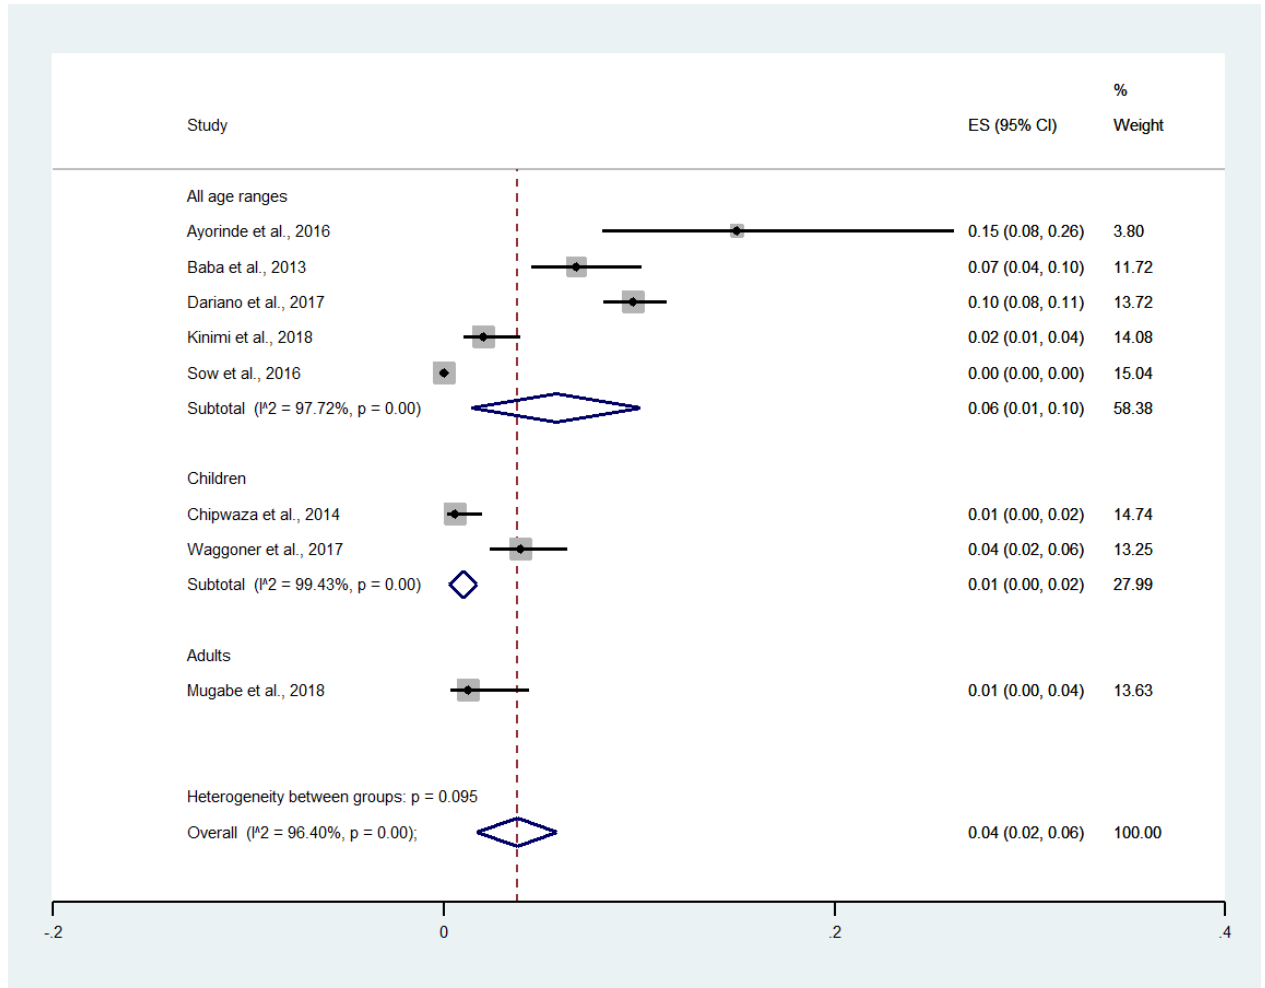
Figure 4. Prevalence of malaria and CHIKV co-infection among febrile patients by age group: % weighted, the impact proportion of each study to the pooled effect; the black dot symbol on the black horizontal line, the point estimate for each study; the black horizontal line, CI; the white diamond symbol, the pooled prevalence; CI, confidence interval; ES, effect size (prevalence).